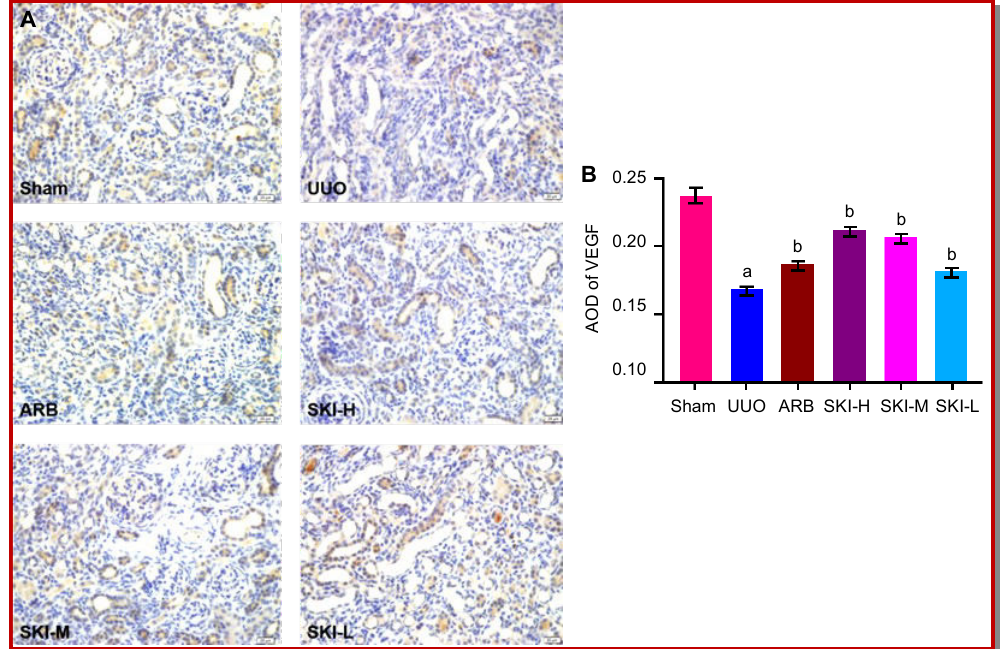
Figure 5: Effects of shenkang injection on expression of VEGF. (A) Expression of VEGF were determined by im- munohistochemistry, 400×; (B) Average optical density (AOD) of positive areas was calculated. Values are present- ed as mean ± SD. a p<0.01 vs sham group, b p<0.01 vs UUO group; ARB means losartan; SKI-H means shenkang injec- tion (7.8 g/kg); SKI-M means shenkang injection (3.9 g/kg); SKI-L means shenkang injection (1.95 g/kg)